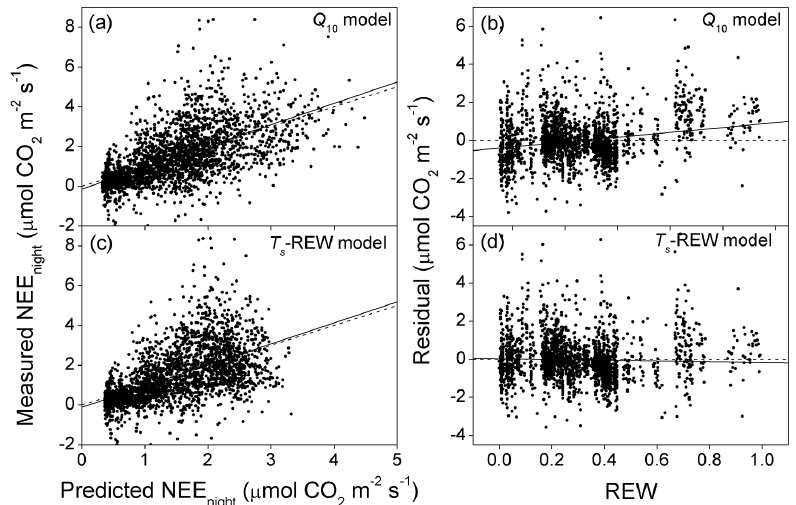
Figure 7. Comparisons of measured and predicted half-hourly nighttime net ecosystem CO 2 exchange (NEE night ) using the Q 10 model (a) and the T s –REW model (c) ; relationships between NEE night residuals and REW for the Q 10 model (b) and the T s –REW model (d) . REW means the relative extractable water content (see Eq. 10). Only data when T s >0 ◦ C were used. The dashed lines in (a) and (c) represent y = x , and those in (b) and (d) represent y = 0. The fit line in (a) : y = 1 . 08 x − 0 . 14, R 2 = 0 . 33, P < 0 . 01; the fit line in (c) : y = 1 . 06 x − 0 . 11, R 2 = 0 . 39, P < 0 . 01. The slope and intercept as well as their 95% confidence intervals (CI) are 1.27 (1.04, 1.50) and − 0.40 ( − 0.48, − 0.32) for the relationship between REW and the NEE night residuals from the Q 10 model (b) , and are − 0.21 ( − 0.43, 0.02) and 0.03 ( − 0.05, 0.11) for the relationship between REW and the NEE night residuals from the T s –REW model (d) .